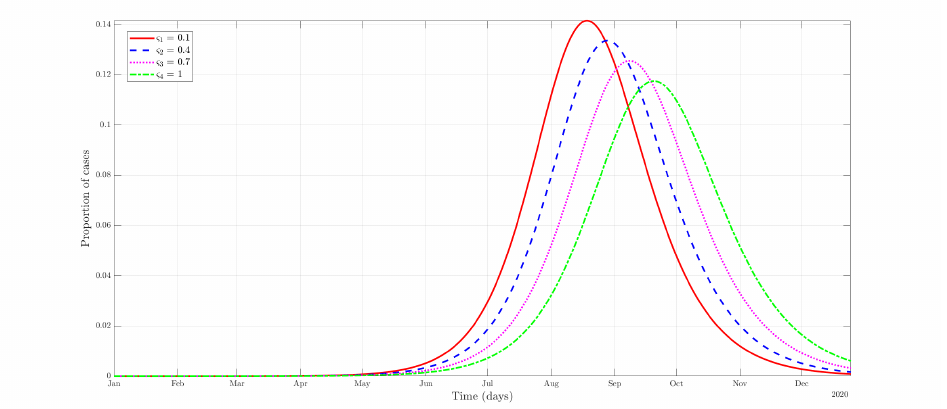
Figure 2. Evolution in the number of cases of the combined infectious category ( A + I ) depends on the strength of social norms ( ς